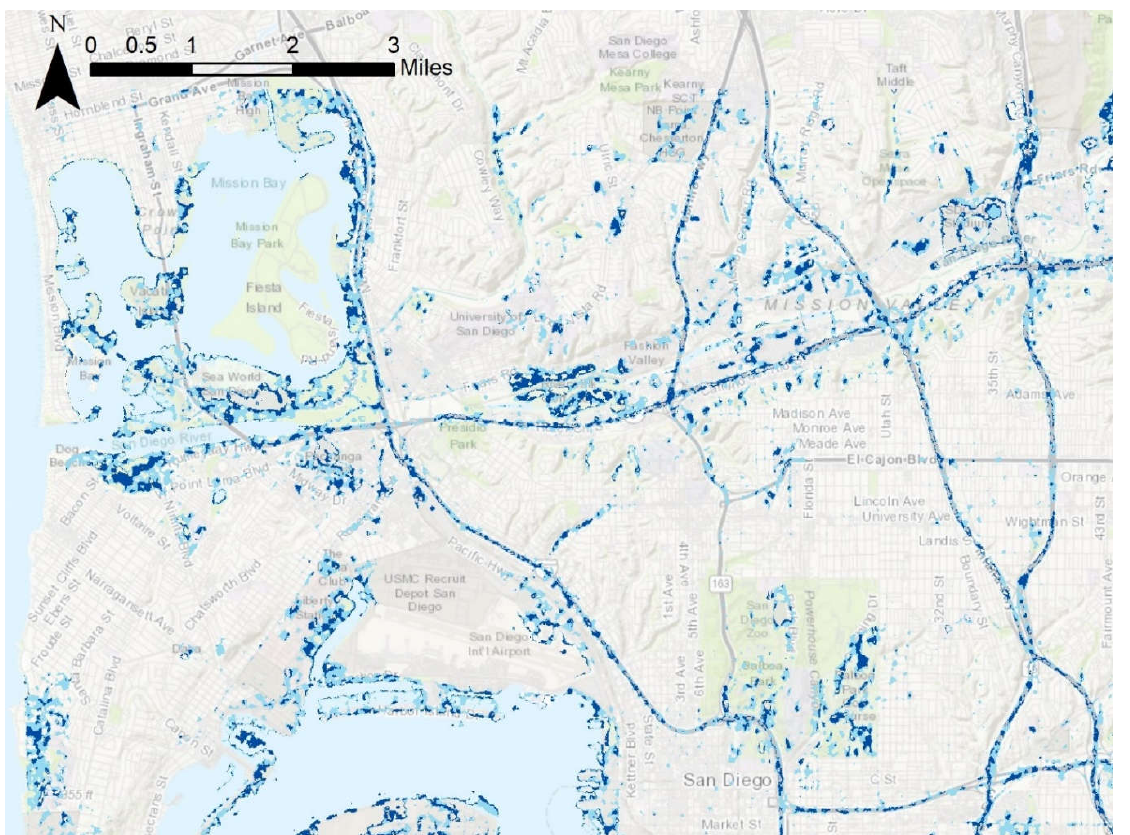
Figure 9. 2017 and 2018 combined flood map based on the Change Detection method. Light blue shading represents areas that experienced flooding in either the 2017 or 2018 weather events while dark blue shadings represent areas flooded by both the 2017 and 2018 weather events.